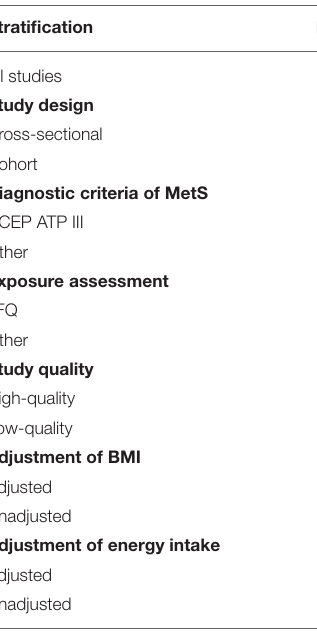
TABLE 3 | Subgroup analyses of refined grain consumption and